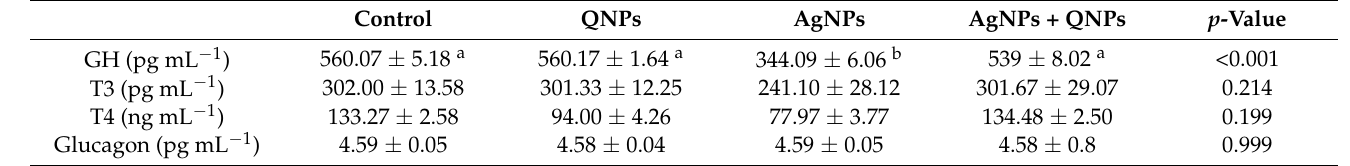
Table 6. Effect of QNPs on hormones in AgNPs-induced toxicity in Nile tilapia.